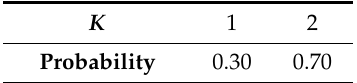
Table 2. The probability mass function of random variable K for our first